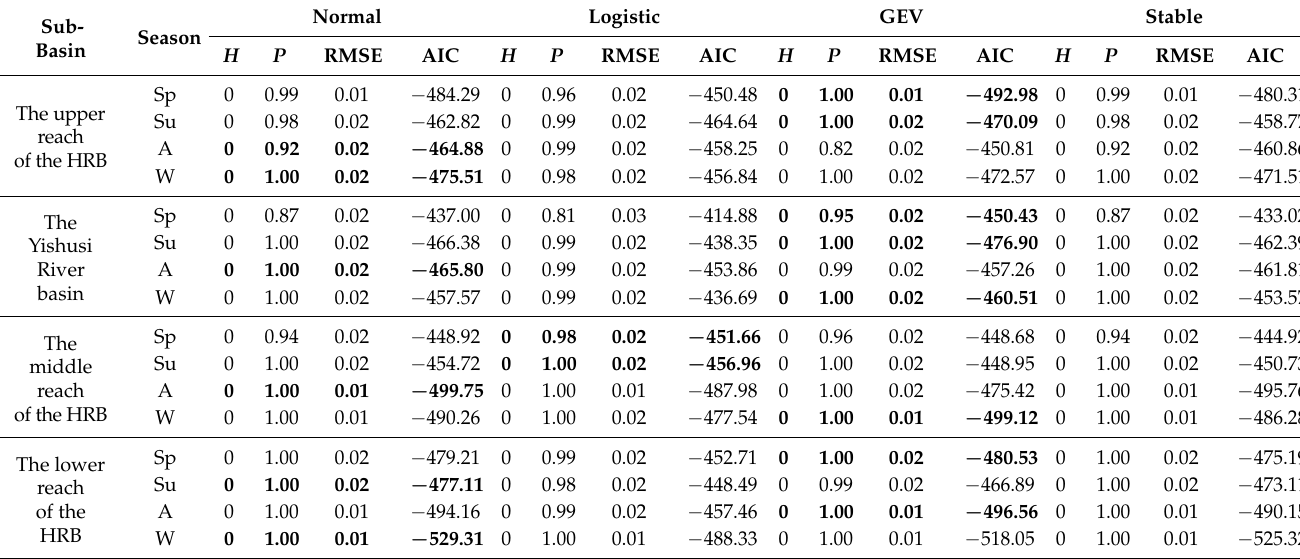
Table 4. The goodness-of-fit of four candidate marginals.